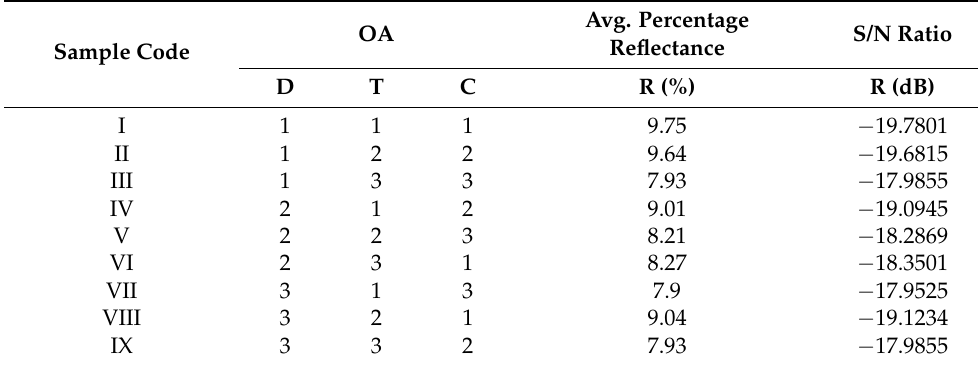
Table 2. The L9 OA, experimental results for avg. percentage